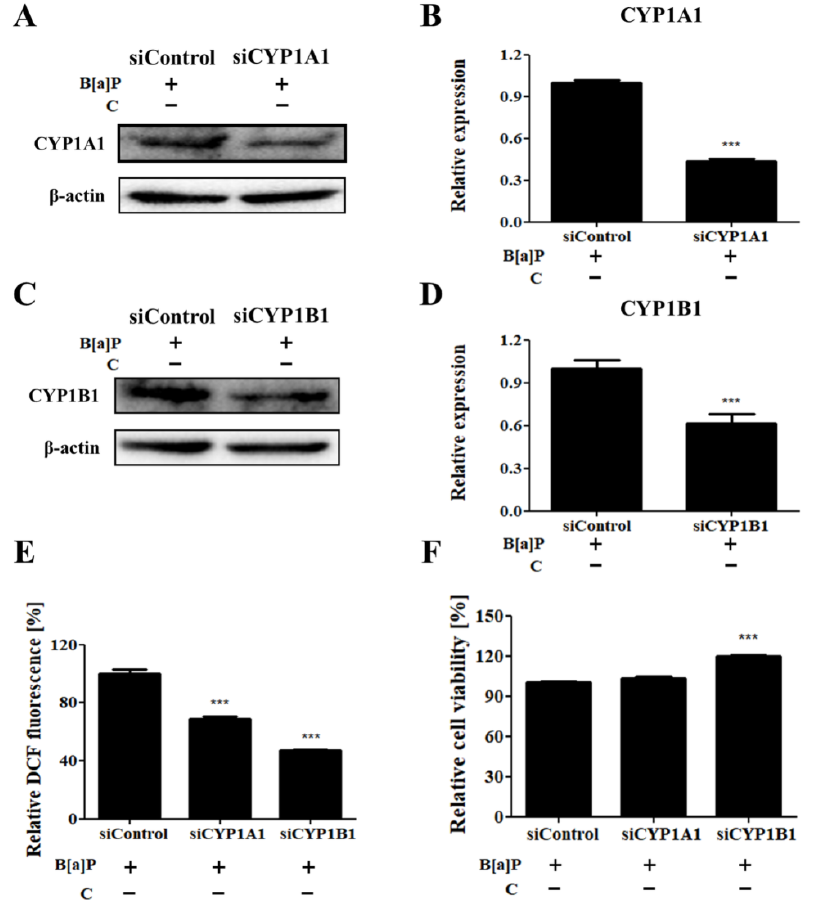
Figure 5. Effects of Cyp1a1 and Cyp1b1 knockdown on B[a]P-induced cytotoxicity and induction of ROS. ( A ) Cyp1a1 knockdown in B[a]P-treated HepG2 cells. ( B ) Relative level of CYP1A1 in siRNA- transfected HepG2 cells compared with the vehicle control. ( C ) Cyp1b1 knockdown in B[a]P-treated HepG2 cells. ( D ) Relative level of CYP1B1 in siRNA-transfected HepG2 cells compared with the vehicle control. N = 3 trials per sample and control. ( E ) Inhibitory effect of Cyp1a1 and Cyp1b1 knockdown on cellular ROS generation induced by B[a]P in HepG2 cells. N = 5 trials per sample and control. ( F ) Ameliorative effect of Cyp1b1 knockdown on B[a]P-induced cytotoxicity in HepG2 cells. N = 3 trials per sample and control. *** p < 0.001, compared with the control. B[a]P: benzo[a]pyrene (10 µM); C: curcumin.